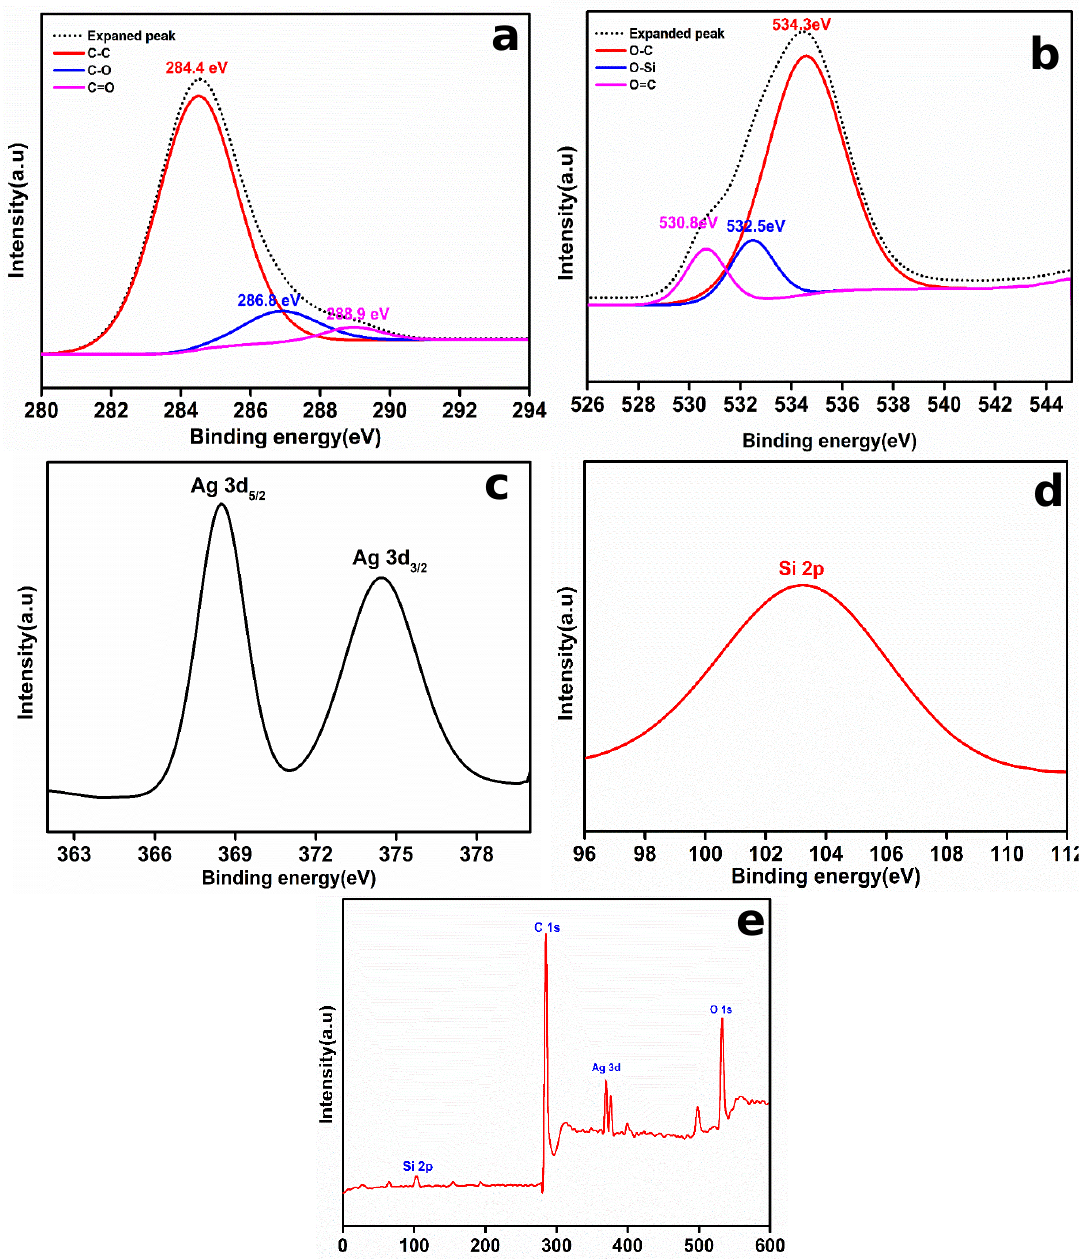
Figure 4. X-ray photoelectron spectroscopy (XPS) spectrum of rGO-Ag@SiO 2 . ( a ) Deconvoluted C 1S spectrum, ( b ) deconvoluted O 1S spectrum, ( c ) expanded Ag 3d spectrum, ( d ) expanded Si 2p spectrum of rGO-Ag@SiO 2 , and ( e ) full survey.